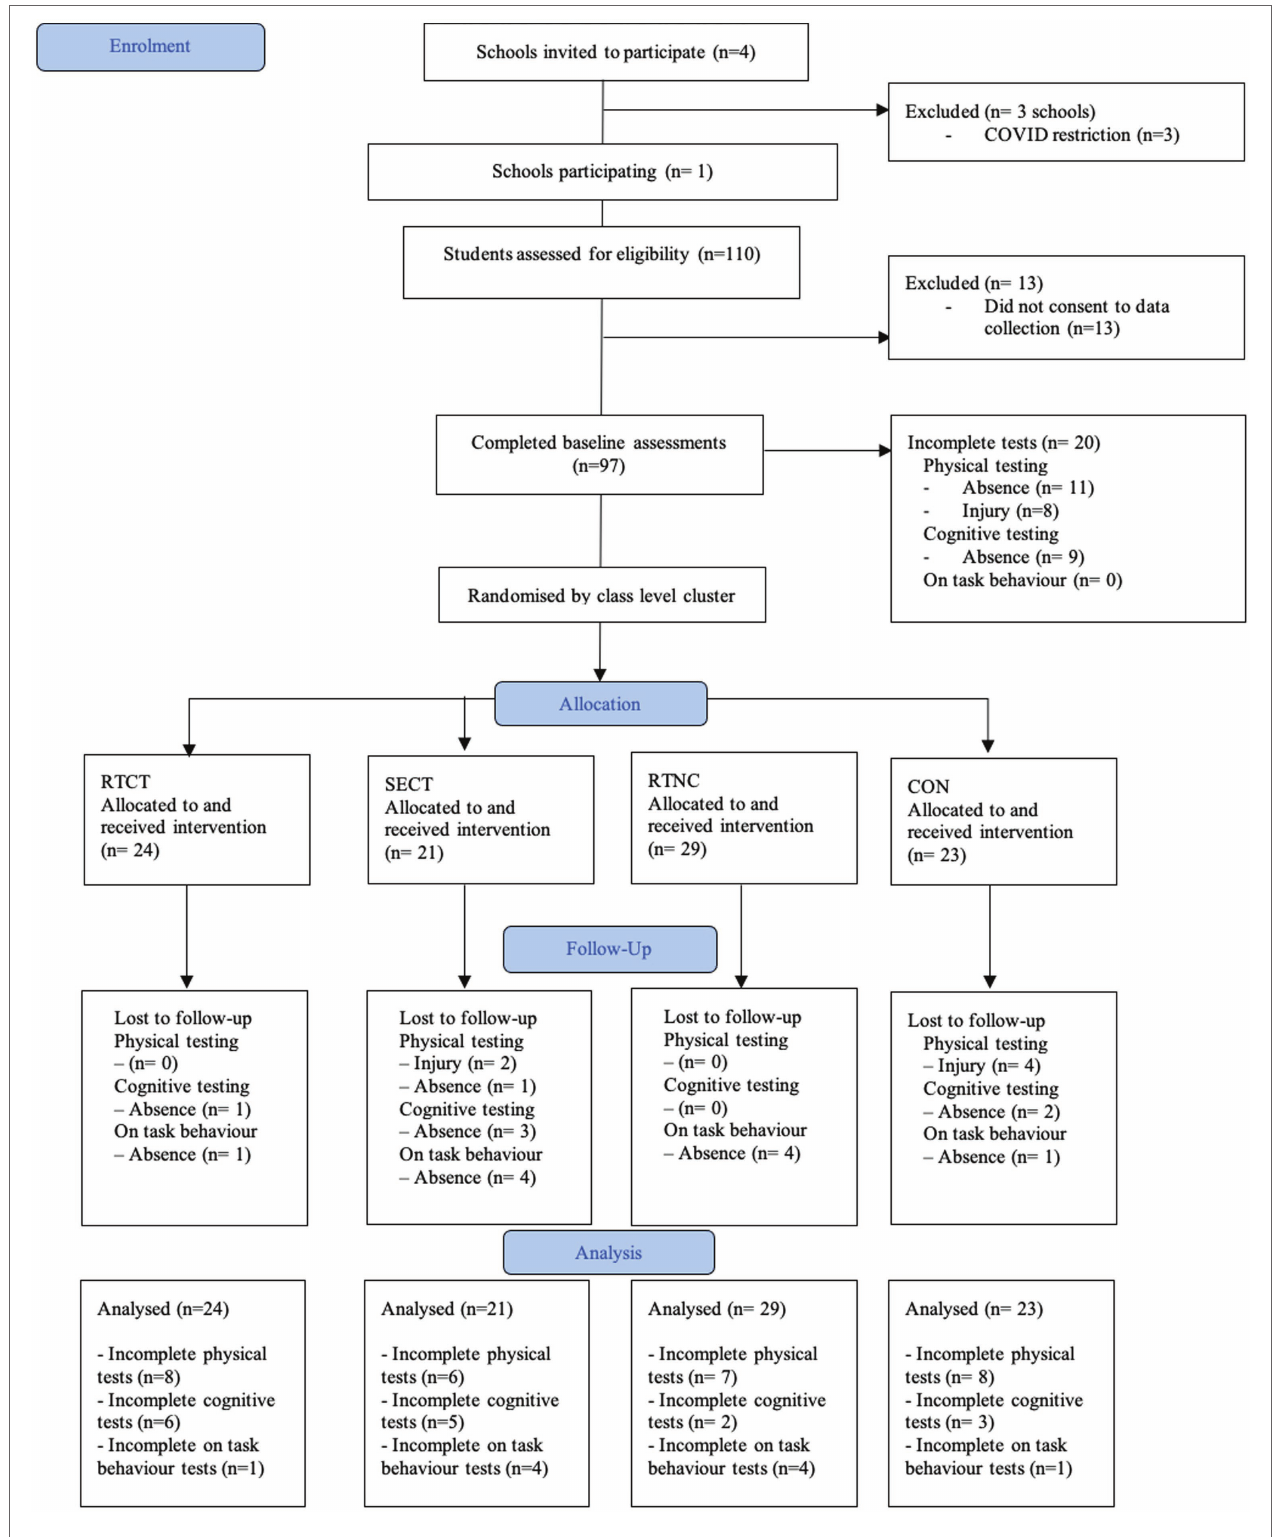
FIGURE 1 | Consort flow diagram of